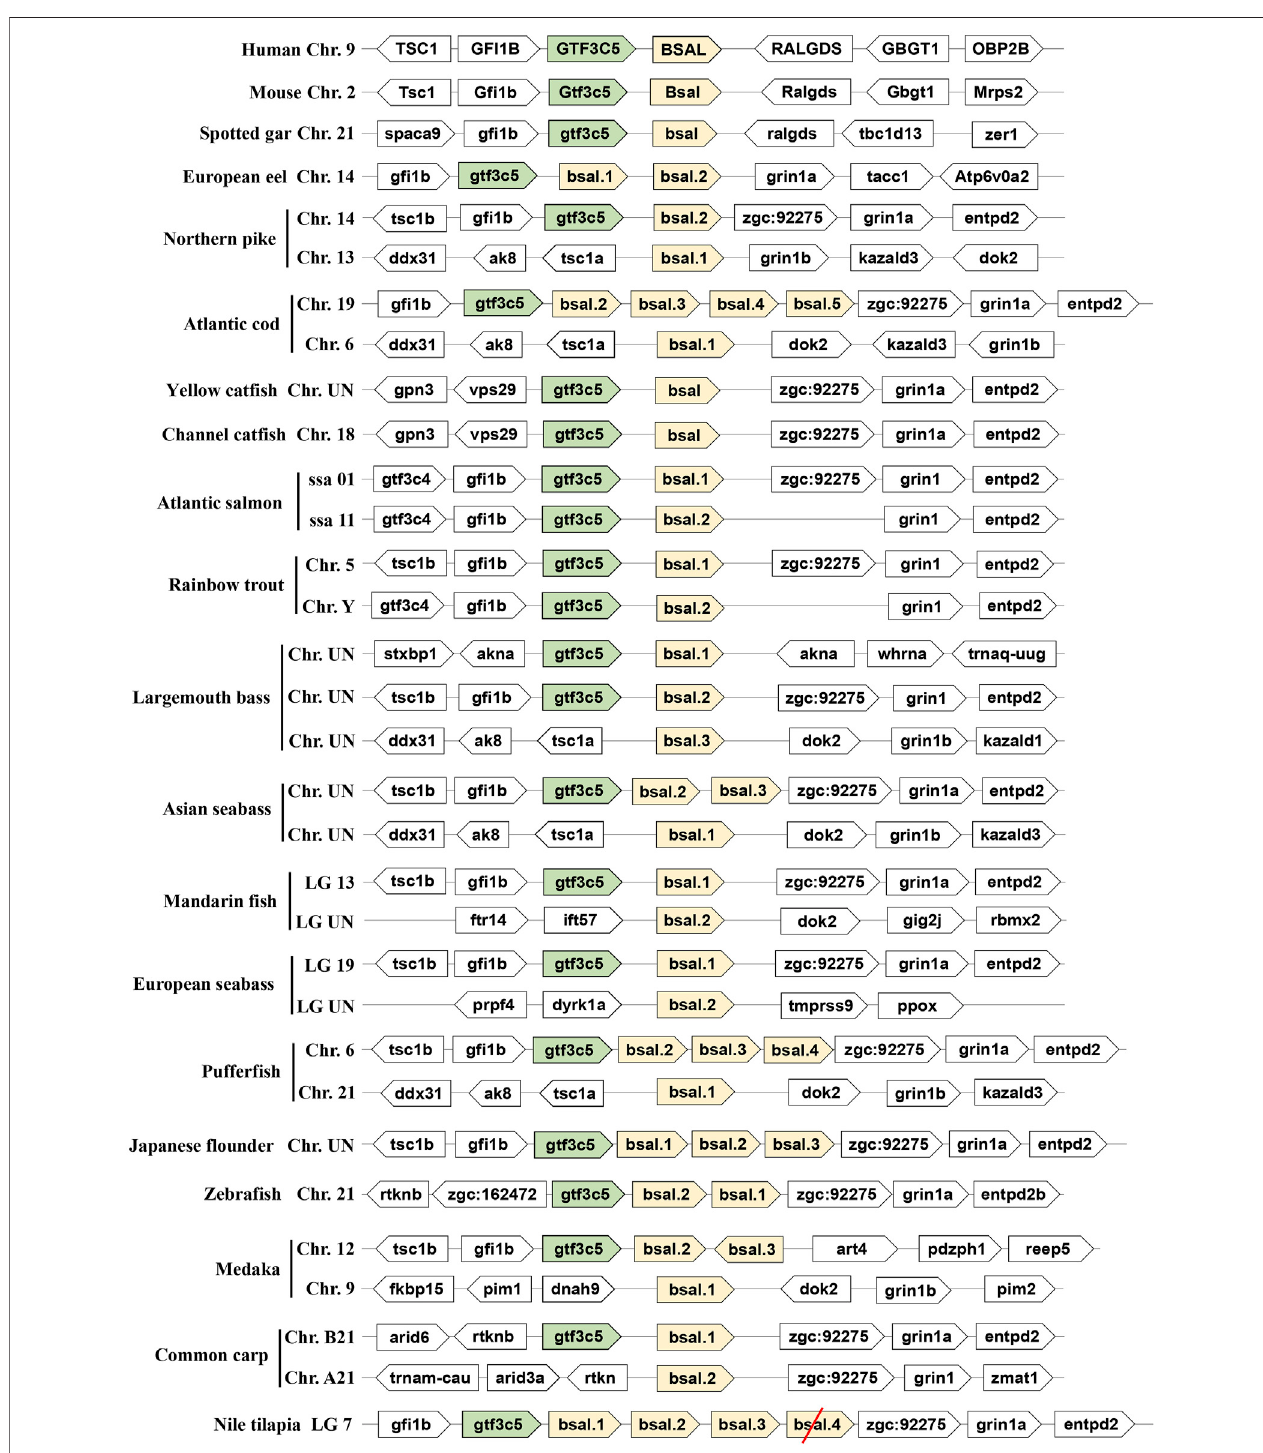
FIGURE 2 | Synteny of bile salt-activated lipase genes (light yellow) in mammals and fi shes. The conserved neighborhood genes ( gtf3c5 ) were marked with green. The pseudogene was marked with a red slash.